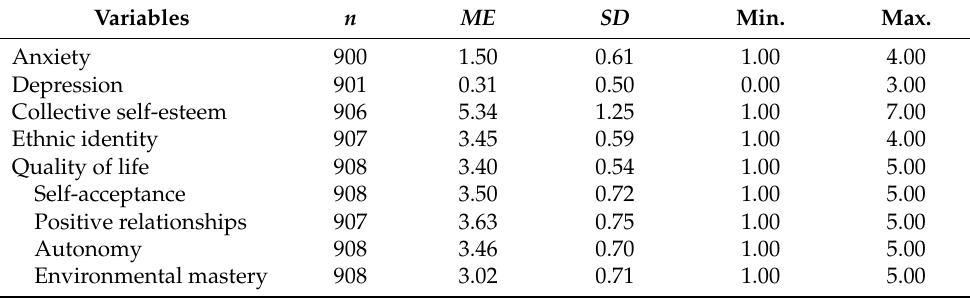
Table A2. Descriptive statistics of the variables included in the